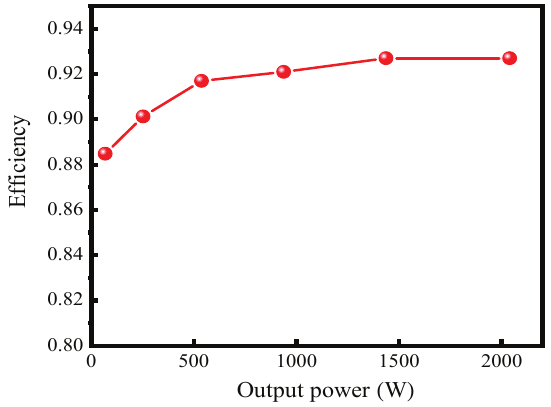
Figure 8. Variation of the efficiency with output